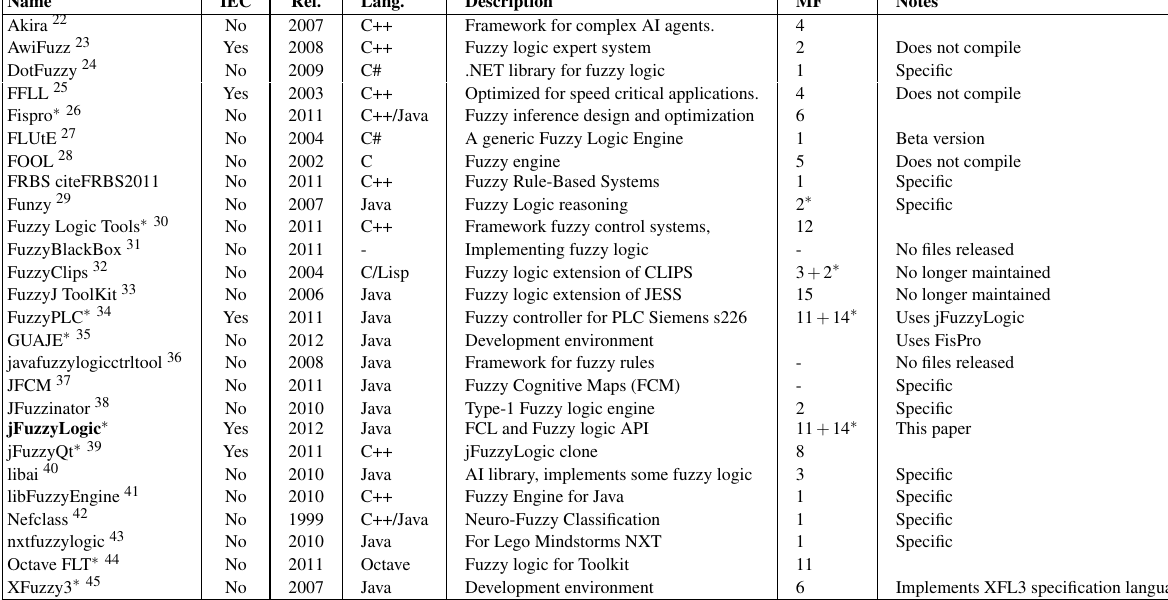
Table 1: Comparison of open fuzzy logic software packages. Columns describe: Project name (Name), IEC 61131-7 language support (IEC), latest release year (Rel.), main programming language (Lang.), short descrip- tion from website (Description), number of membership functions supported (MF) and Functionality (notes). Name ∗ : package is maintained, compiles correctly, and has extensive